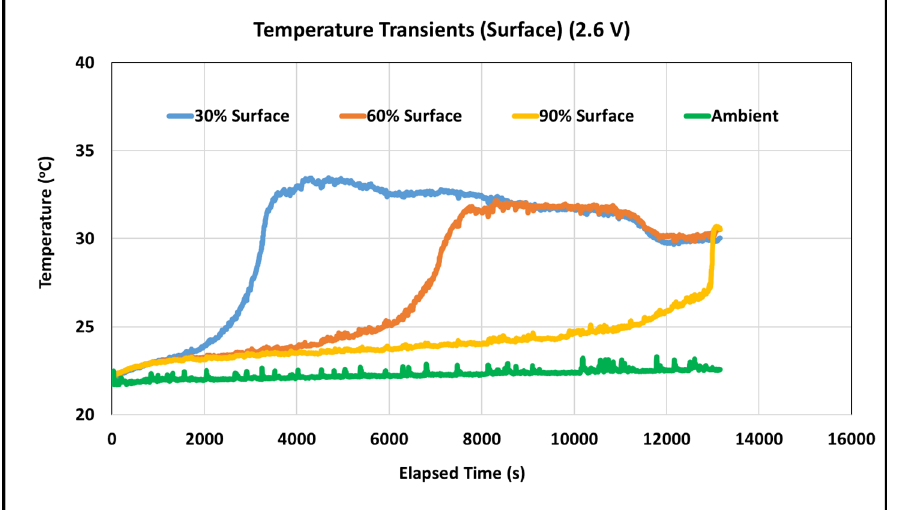
Figure 5. Plot of transient surface-temperature data for heater input voltage of 2.6 V (1.4 W power input).